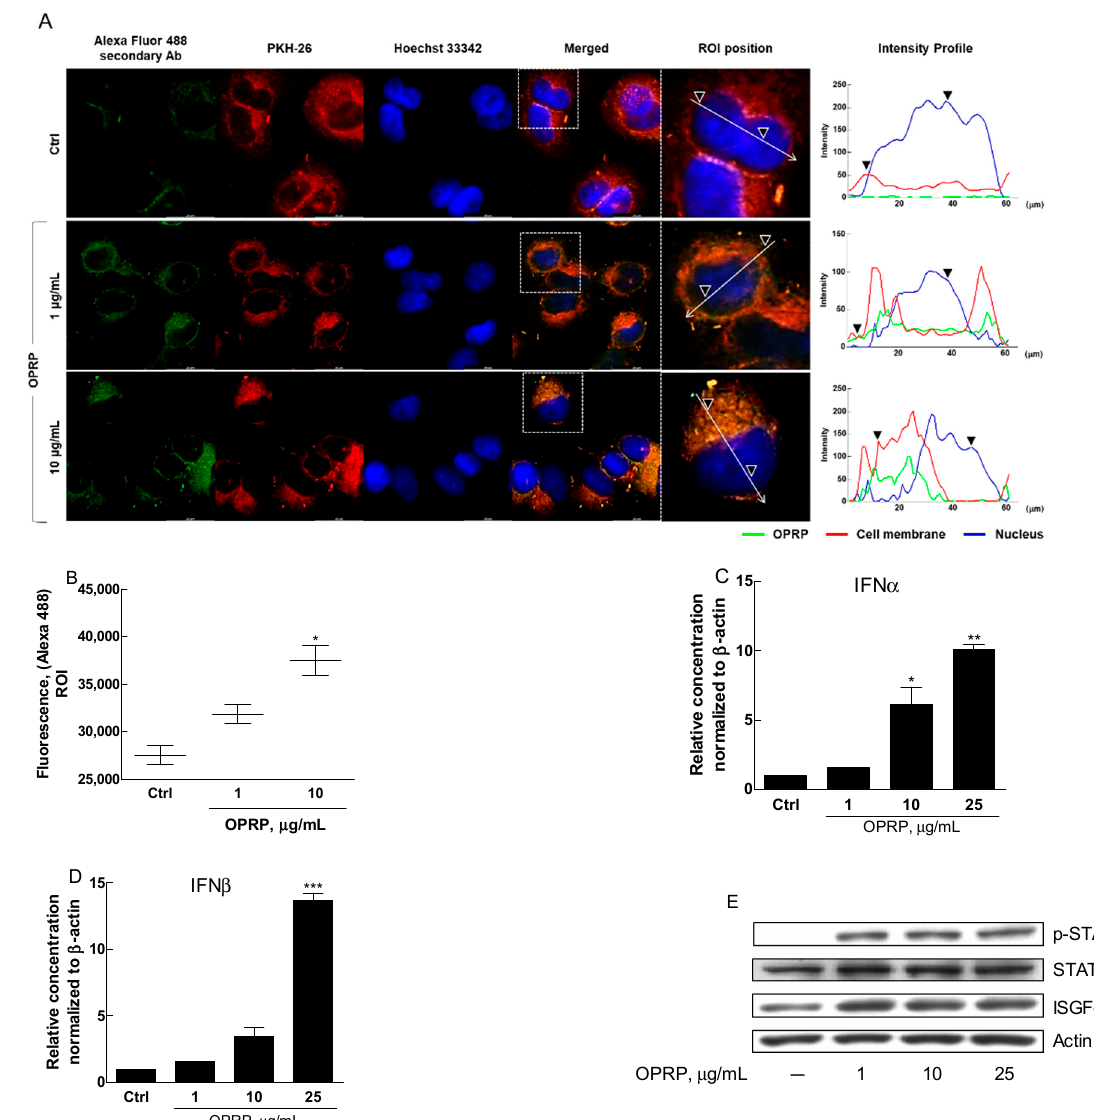
Figure 3. Immunocytochemistry and type I IFN-mediated signaling in A549 cells. A549 lung epithelial cells were treated with OPRP for 4 h. ICC analysis was then performed with a confocal fluorescence microscope. ( A ) OPRP was detected by Alexa Fluor 488-conjugated secondary antibody. Phospholipid (membrane) was compared by lipophilic PKH-26 staining. Hoechst 33,342 was counterstained for nuclear staining (arrow indicates a magnified single cell picked from a merged picture, whereas outer and inner triangle indicates cell membrane and nuclear, respectively). Scale bar, 20 µ m. ( B ) Intensity profiles (a region of interest, ROI) obtained with ImageJ plot analysis are shown. ( C , D ) mRNAs of type I-dependent cytokines IFN- α and IFN- β were analyzed in the presence of OPRP (1, 10, and 25 µ g/mL) for 20 h in A549. ( E ) Phosphorylation of STAT1 and expression of ISGF-3 γ in A549 were assessed by Western blot. Results are presented as means ± standard deviations from three separate experiments. * p < 0.05, ** p < 0.01, *** p < 0.001 vs. Ctrl.